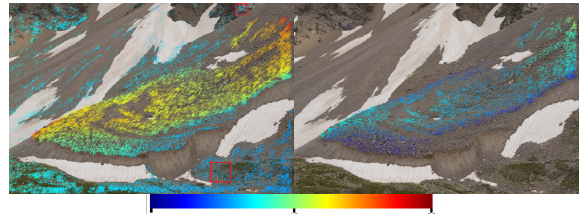
Figure 4. Pixel displacements calculated between 07/07/2016 and 06/09/2016 on the Laurichard rock glacier. (The arrow lengths have been scaled by a factor 5 to improve visibility). Left: before registration. Right: after registration. After the registration the displacement over fixed areas is corrected and close to zero. The red rectangles show the areas considered for the numerical analysis of displacement over fixed areas (see Figure